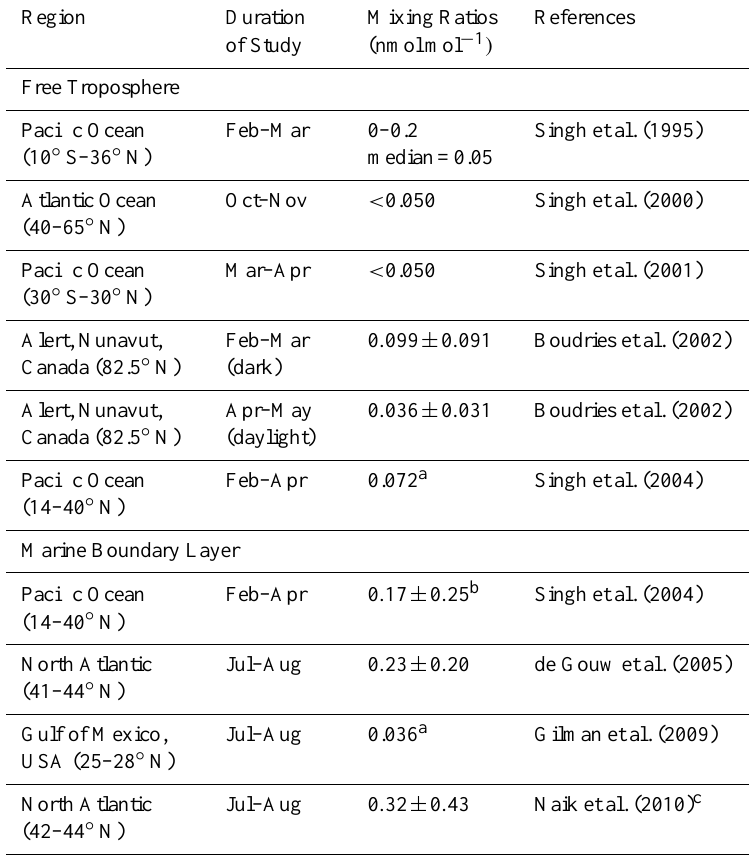
Table 3. Mean mixing ratios of ethanol in the free troposphere and marine boundary